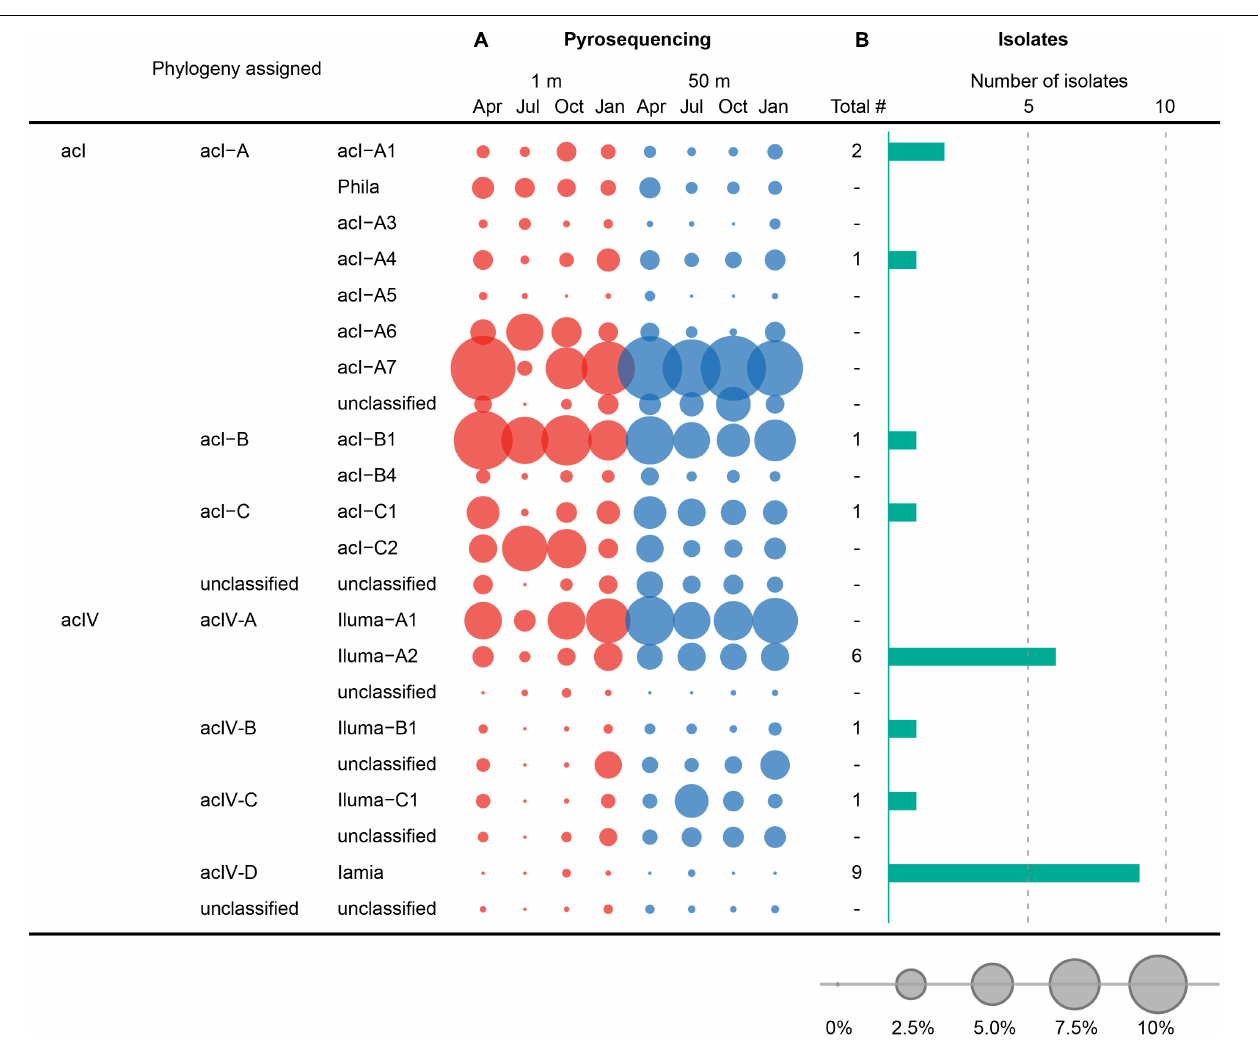
FIGURE 6 | Comparison between the composition of HTC isolates and pyrotags at the tribe level belonging to the acI and acIV lineages of the phylum Actinobacteria . (A) Seasonal variation of tribes of the acI and acIV lineages, observed at 1 and 50 m depths in Lake Soyang, as characterized by 16S rRNA gene pyrosequencing. (B) Number of HTC isolates belonging to tribes of the acI and acIV linages. The bubbles represent the percentage of pyrotags of each taxonomic group in each sample. Taxonomic classification of 16S rRNA gene sequences of HTC isolates and pyrotags was determined using the freshwater-specific FreshTrain database (Rohwer et al.,